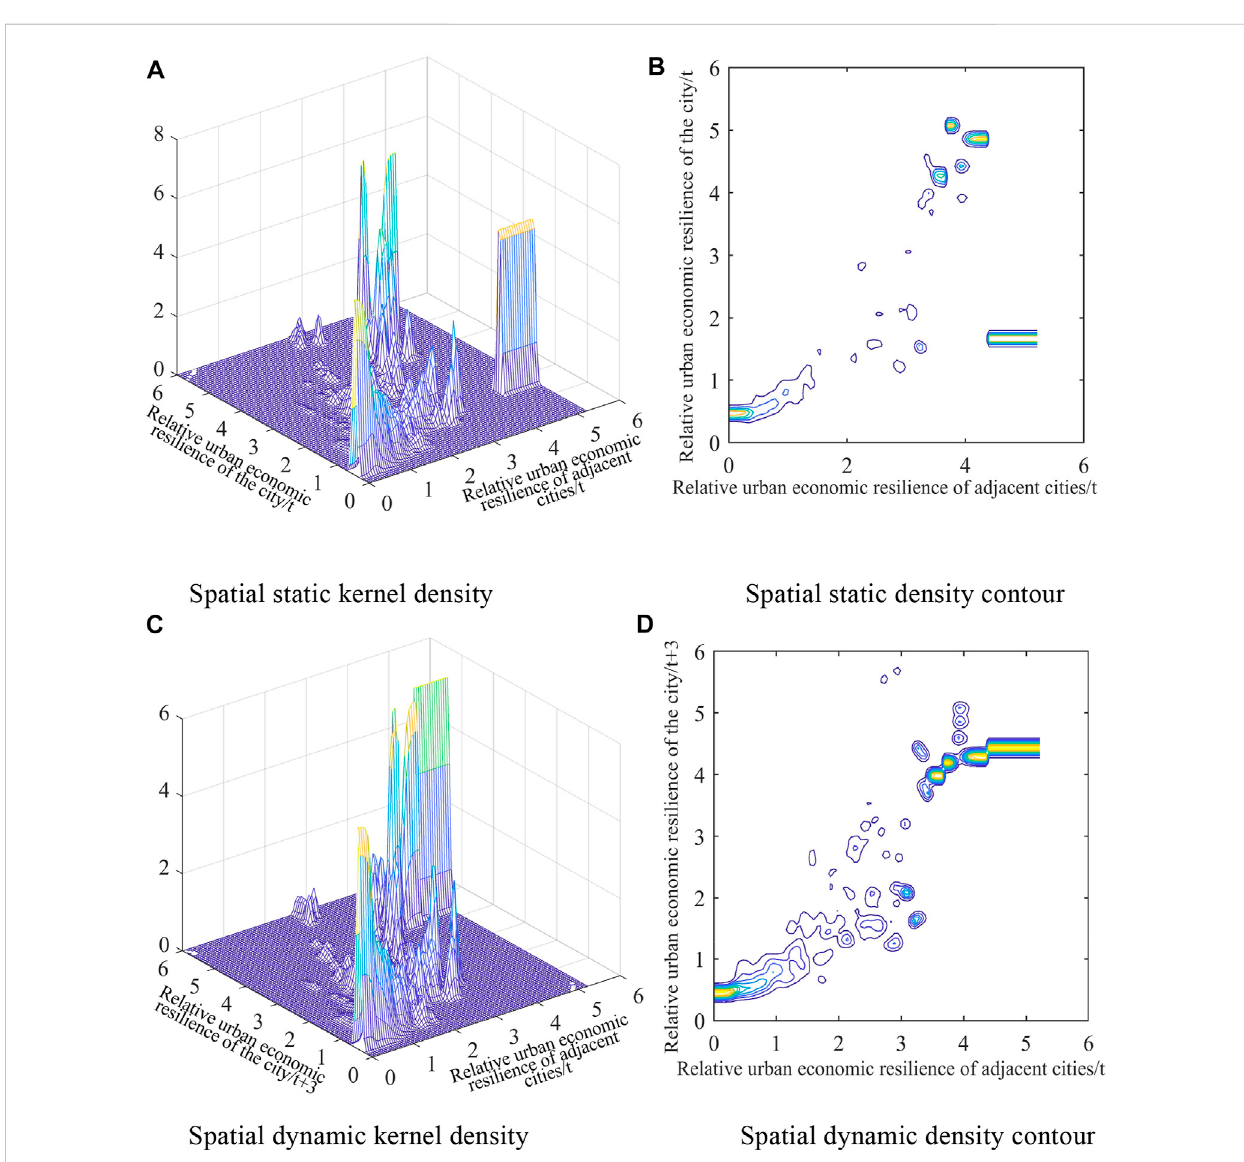
FIGURE 7 Spatial kernel density of economic resilience in Chinese cities. (A) Spatial static kernel density. (B) Spatial static density contour. (C) Spatial dynamic kernel density. (D) Spatial dynamic density